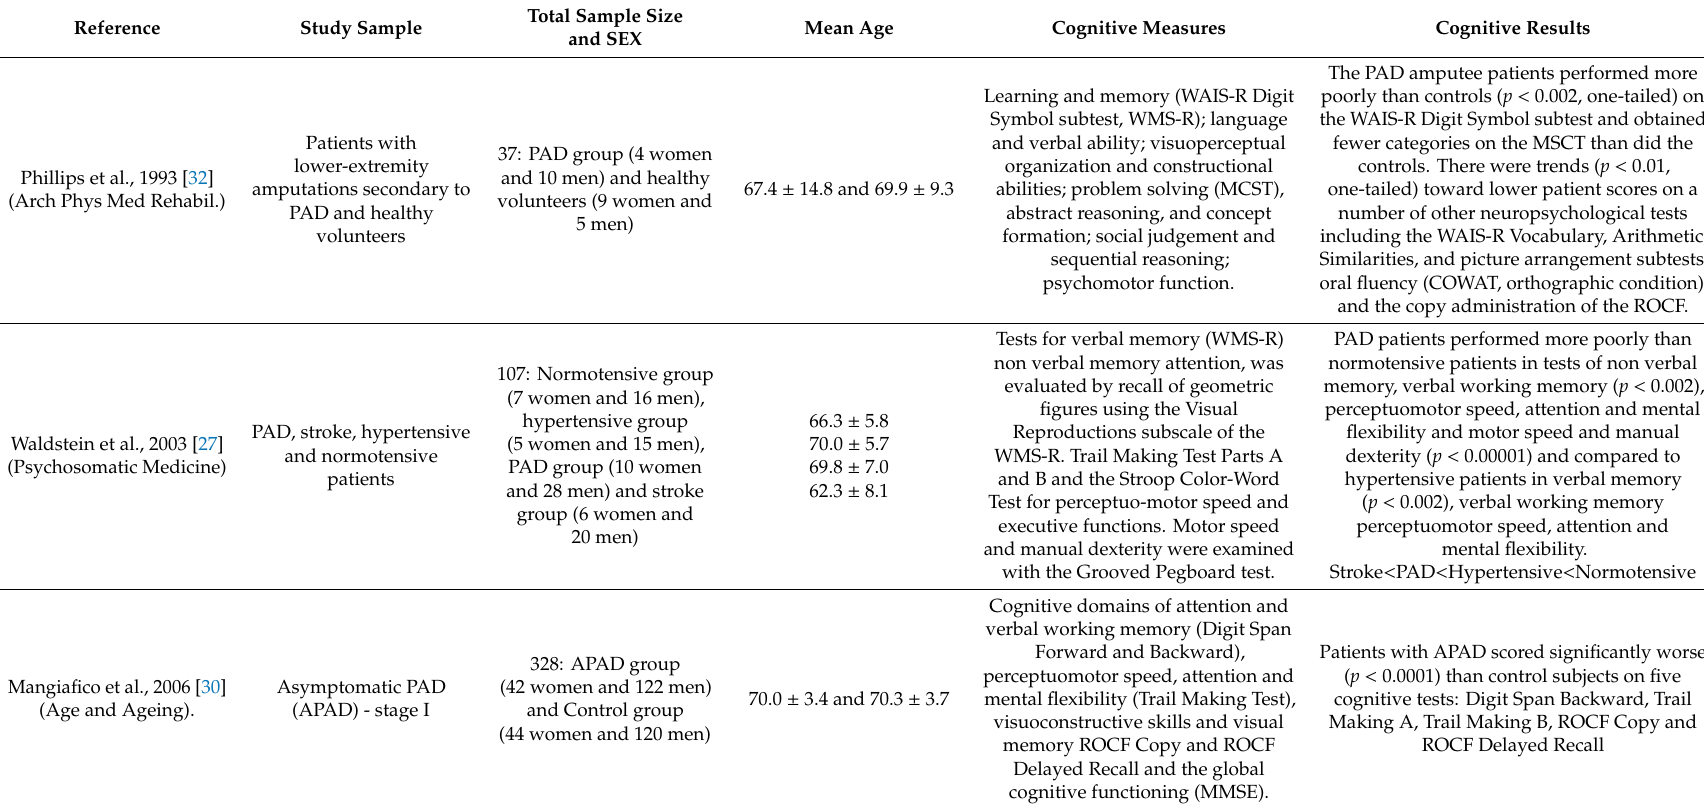
Table 1. Cognitive function in PAD